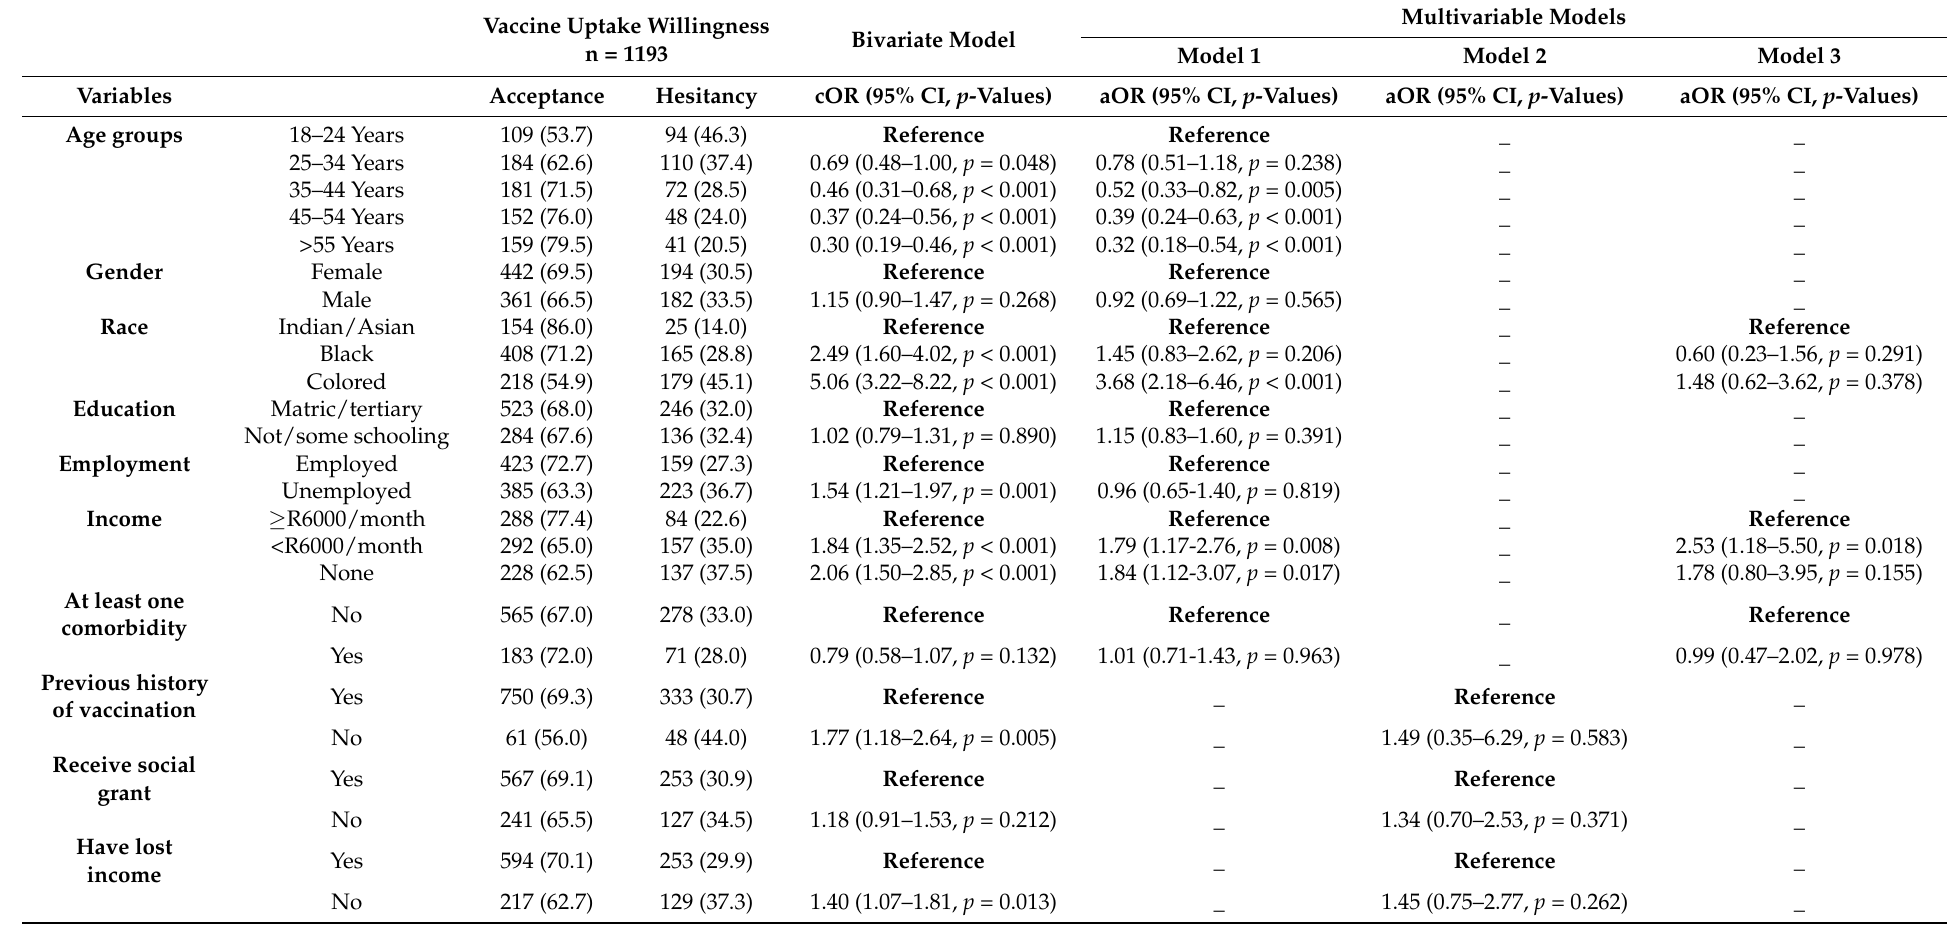
Table 2. Determinants associated with COVID-19 vaccine hesitancy among South Africans surveyed from the 6th of June to the 30th of July 2021. Multivariate logistic models consider first sociodemographic factors, then COVID-19 and COVID-19 vaccine-related factors, then the two